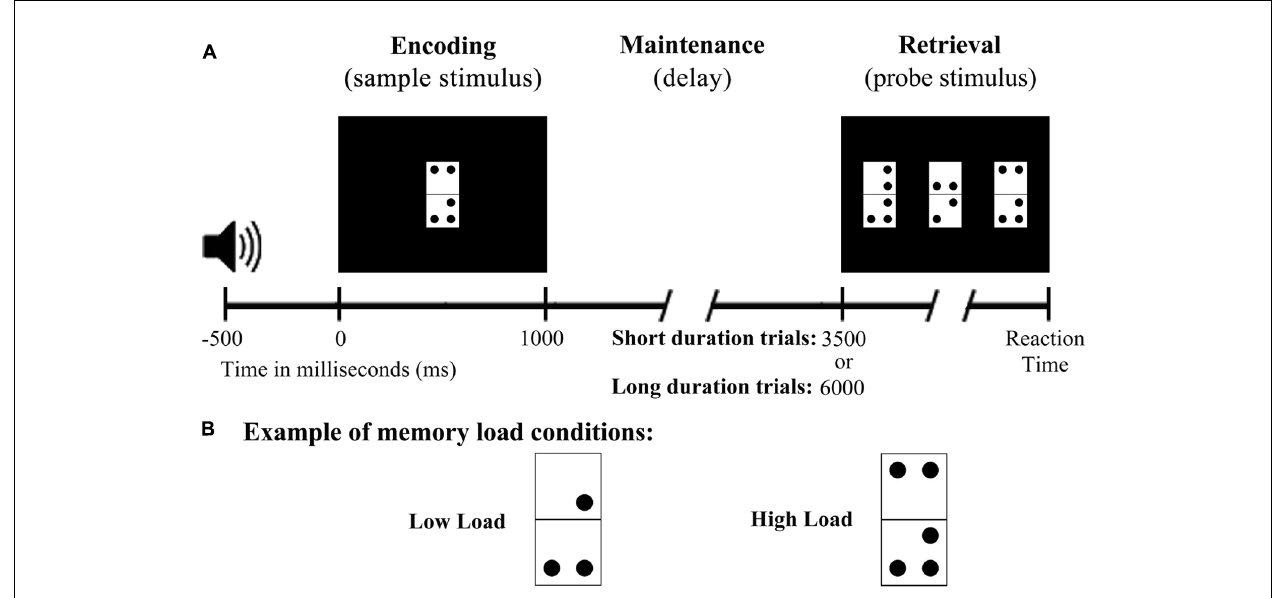
FIGURE 1 | Diagram of the delayed match to sample task used in the study. (A) Schematic illustration of the time course of a single trial. (B) Example stimulus from both memory load conditions.